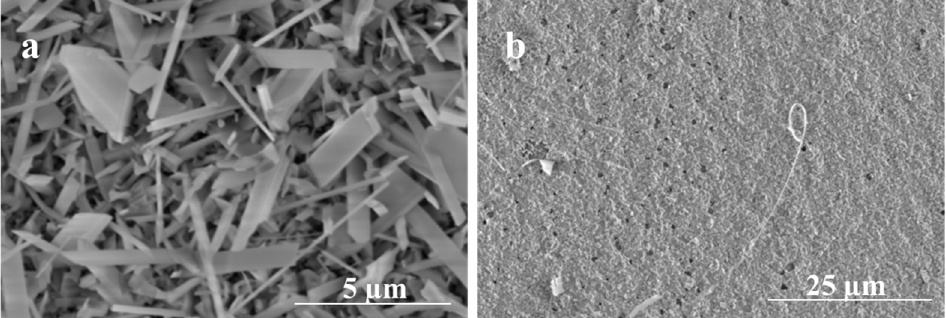
Figure 11. SEM images of Ga 2 O 3 obtained at 1000 °C for 5 min. ( a ) Denser growth of nanowires using 5 nm Ag. ( b ) Nanocrystalline grains growth using 300 nm Ag.